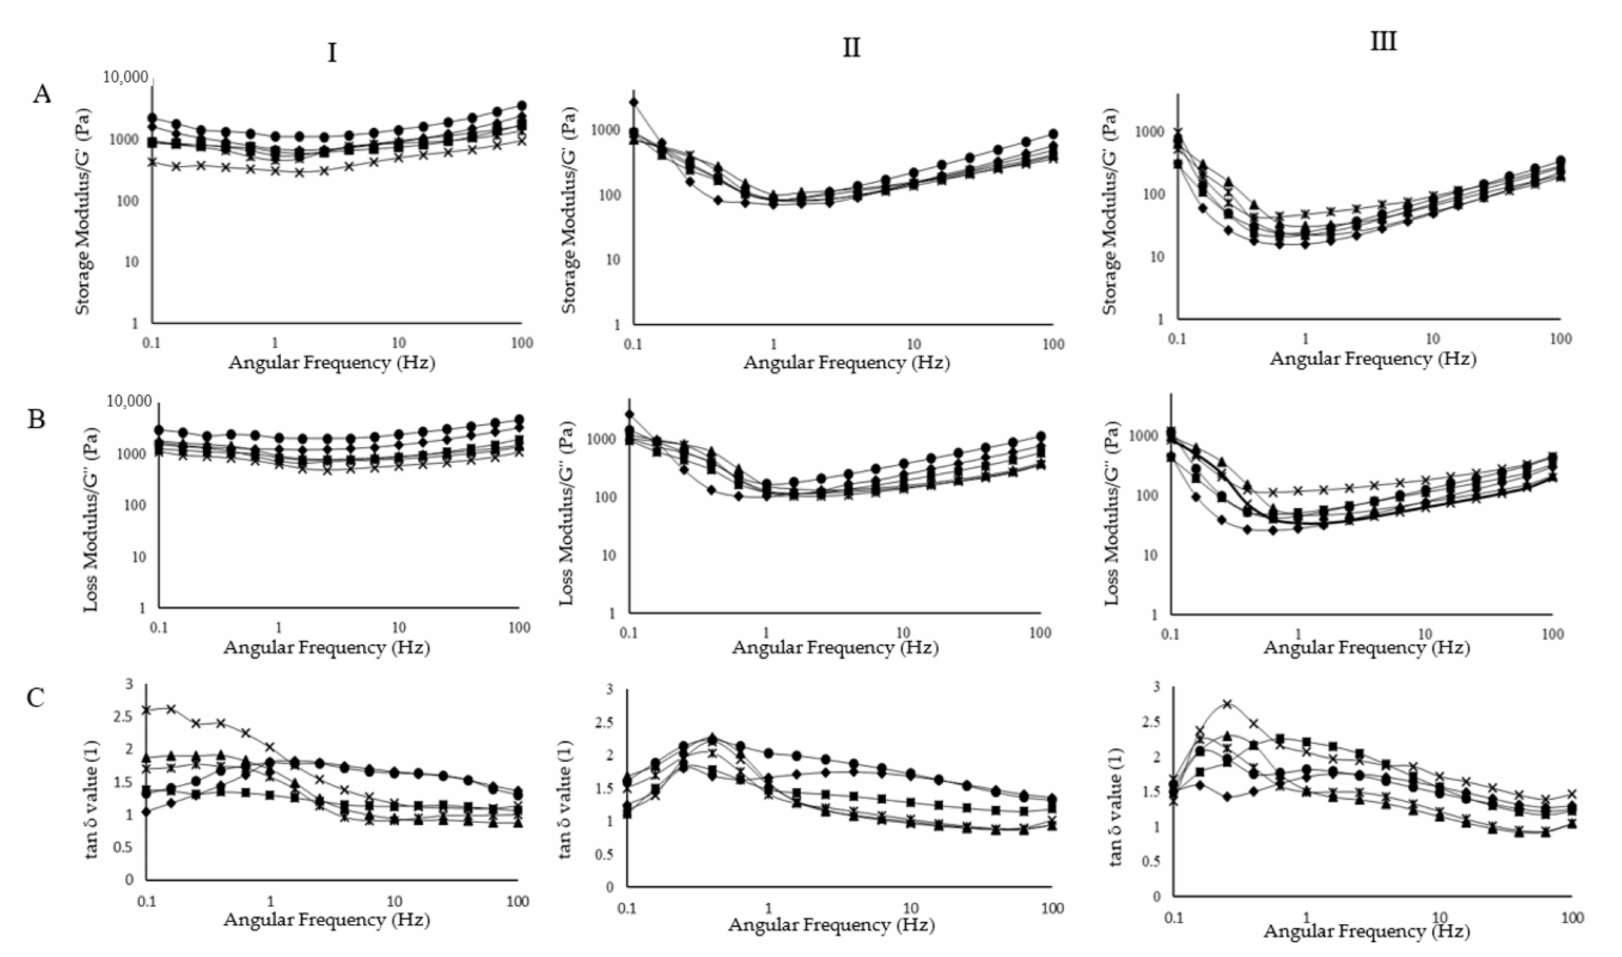
Figure 1. Frequency sweep of GF batter performed at 100–0.1 Hz: ( A ) storage modulus, ( B ) loss modulus, ( C ) tan δ value, ( I ) starch:water ratio 1:0.9, ( II ) starch:water ratio 1:1.3, and ( III ) starch:water ratio 1:1.7, exlude the buckwheat starch ( I ) starch:water ratio 1:1, ( II ) starch:water ratio 1:1.5, and ( III ) starch:water ratio 1:2. The symbols correspond to: × corn starch, * wheat starch, (cid:4) potato starch, (cid:78) cassava starch, • rice flour, and (cid:7) buckwheat